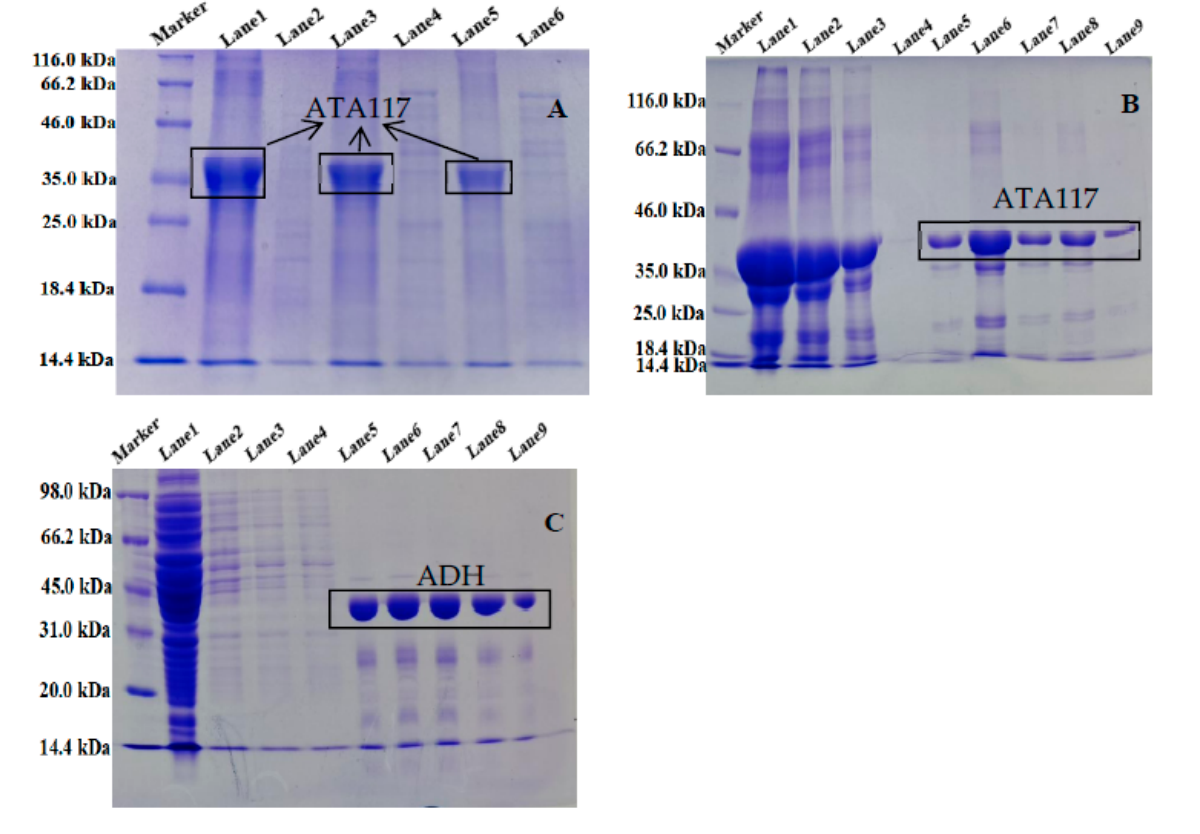
Figure 2. The SDS-PAGE analysis of ATA117 expressed by bacteria transformed with pETDuet-